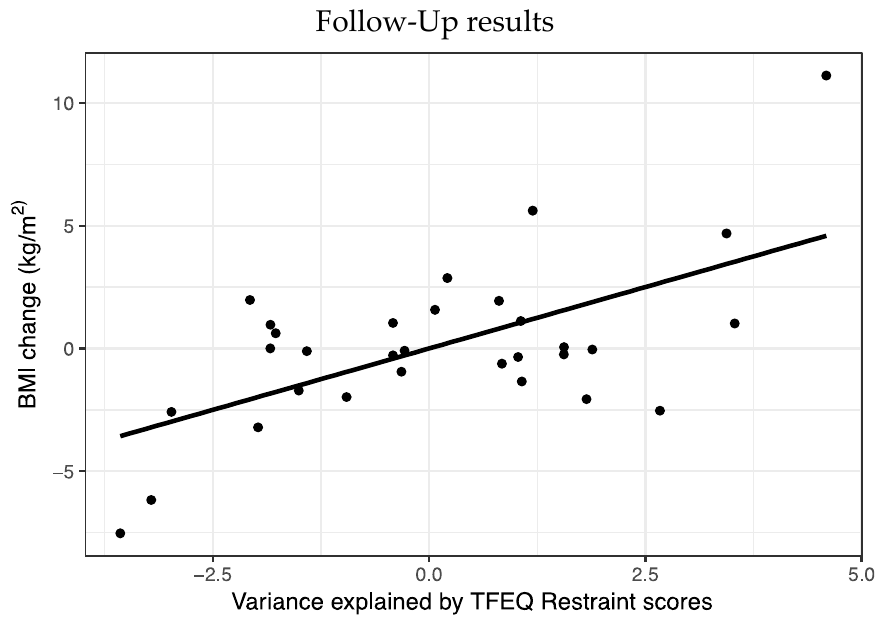
Figure 3. Three Factor Eating Questionnaire (TFEQ) Restraint scores significantly predicted BMI change after three years (plotted with ggplot for R (R Core Team, 2015; Wickham, 2016)). Statistically, this model significantly predicted BMI (F 5,30 = 3.05, p = 0.03, R 2 = 0.38). Of the five variables, only Restraint scores (t = 3.54, p = 0.002) predicted BMI change with higher weight at